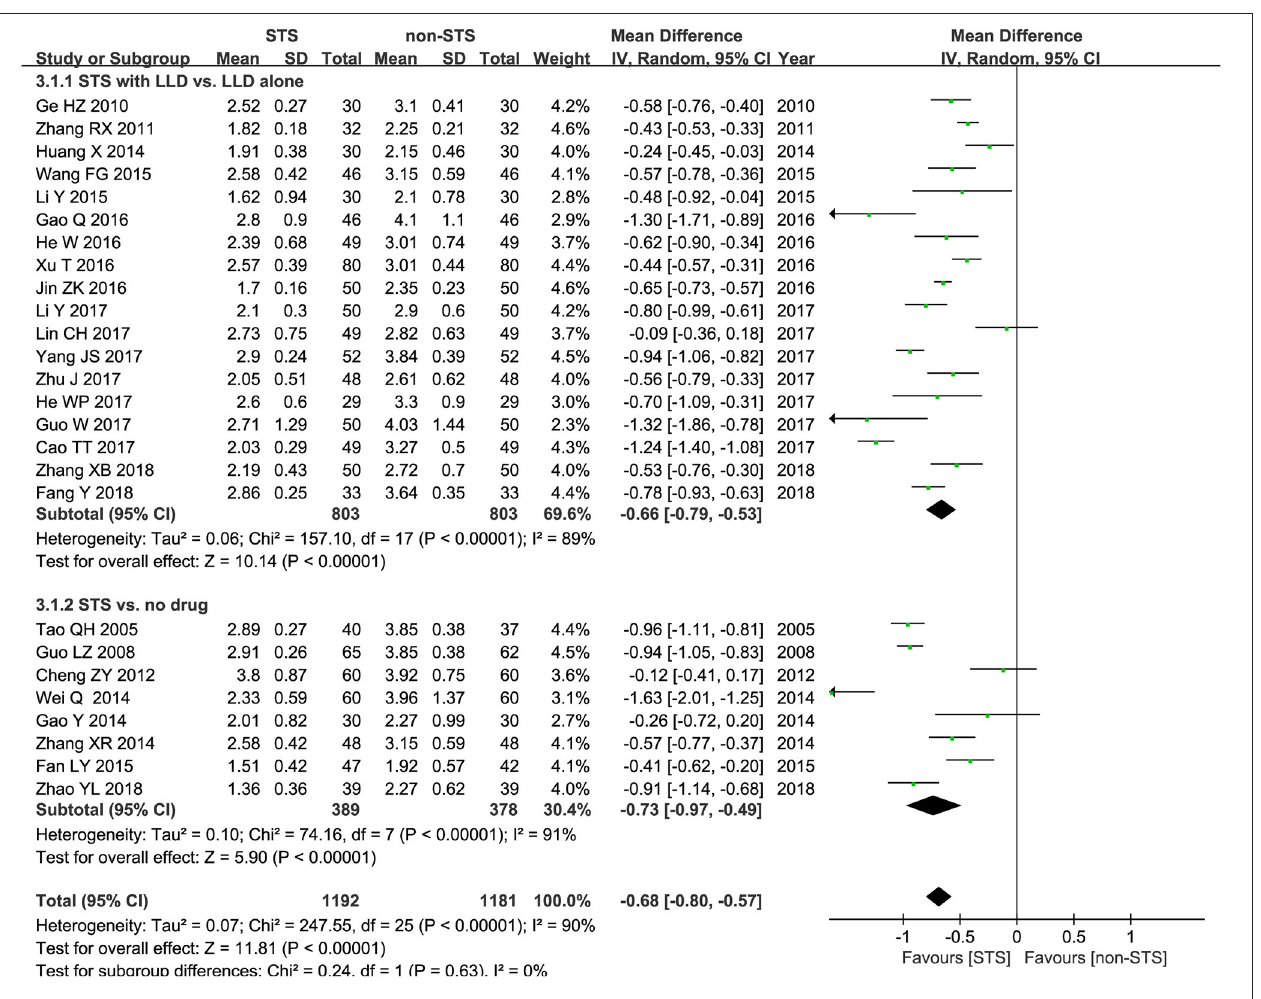
FIGURE 5 | Forest plot of comparison: STS vs. non-STS in